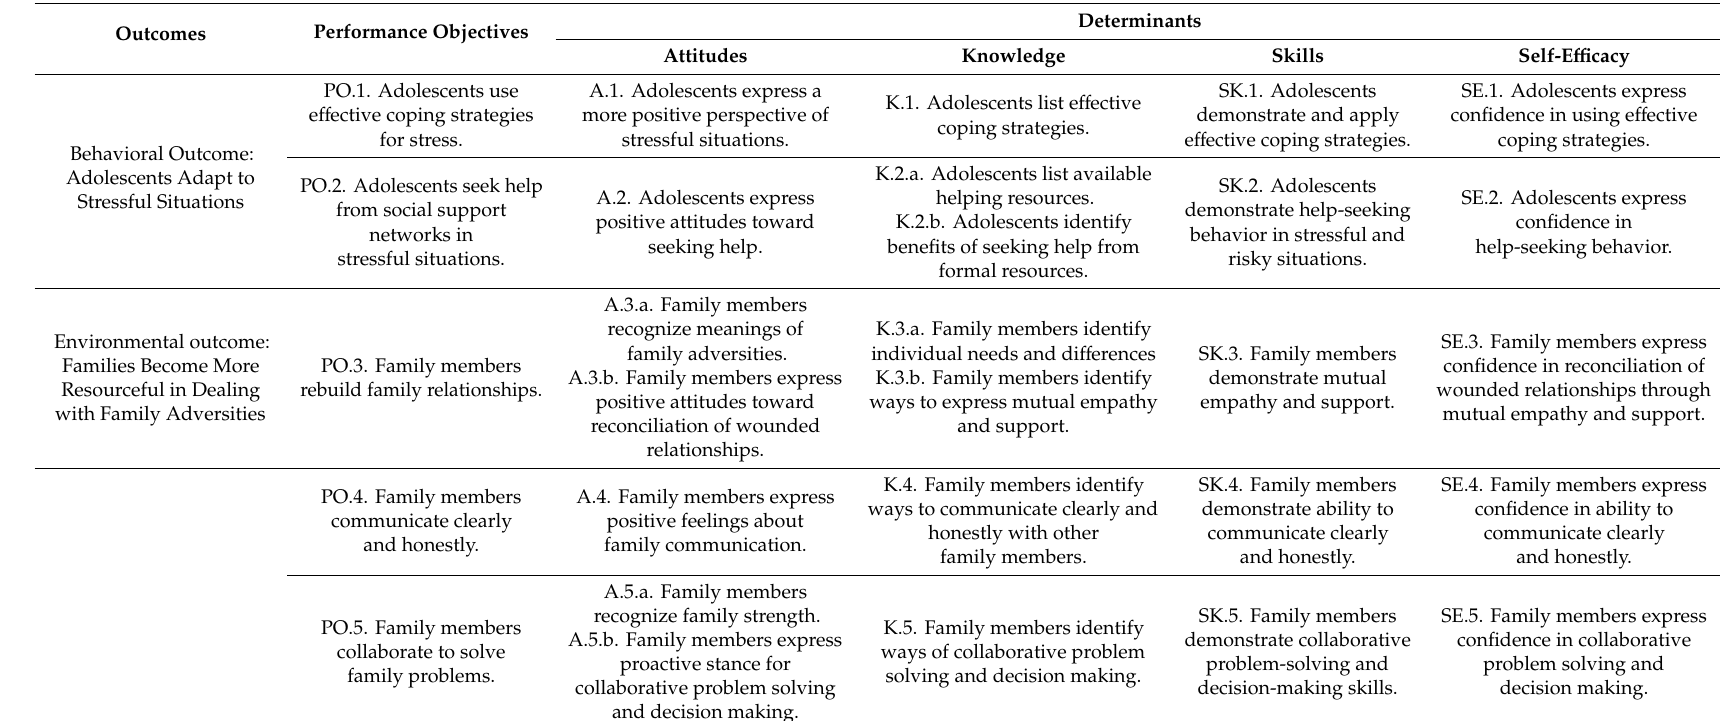
Table 1. Matrix of behavioral and environmental